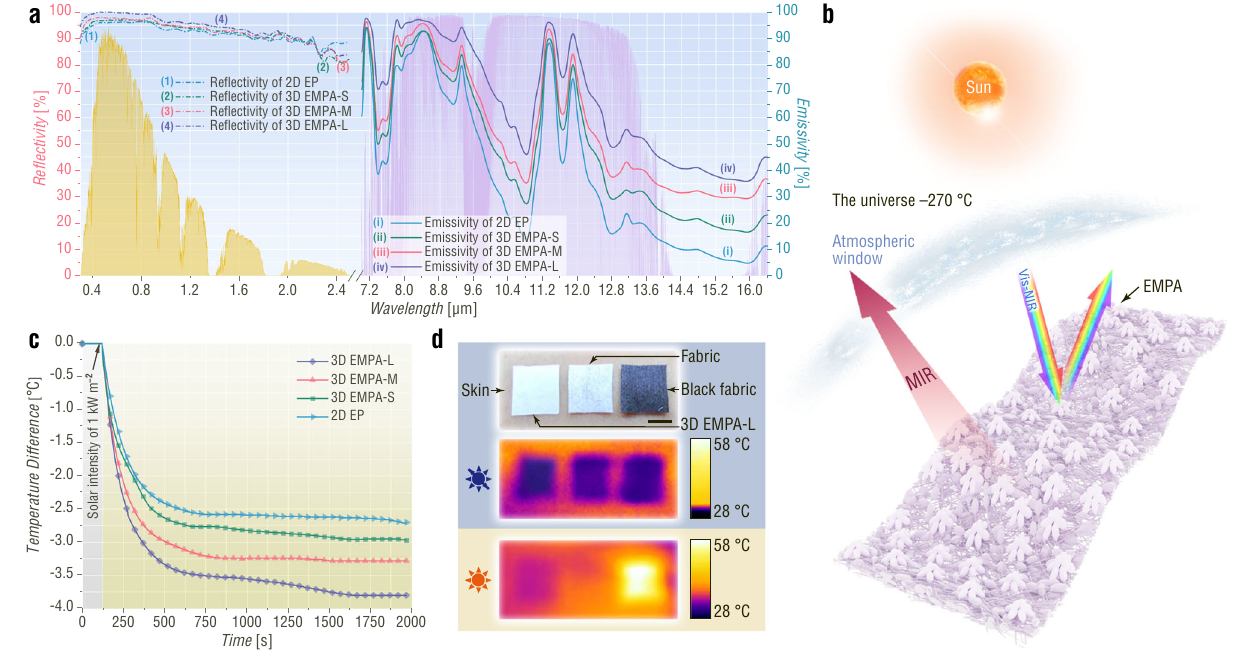
c Temporal temperature difference pro fi le measured for electrospun- fi lm-based radiative cooling fabrics. d Photograph and thermal camera images of the on-skin EMPA-based fi lm, white cotton-containing fabric, and black cotton-containing fabric before and after solar irradiation for approximately 8min. Scale bar,